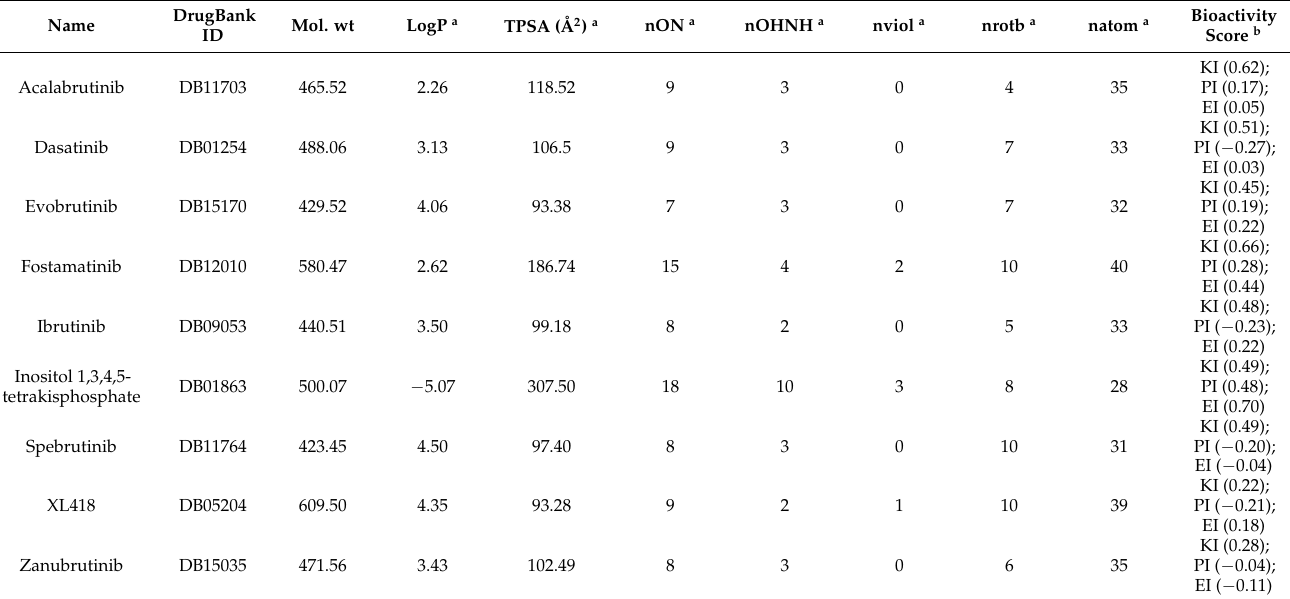
Table 1. Molecular properties and bioactivity scores of the selected